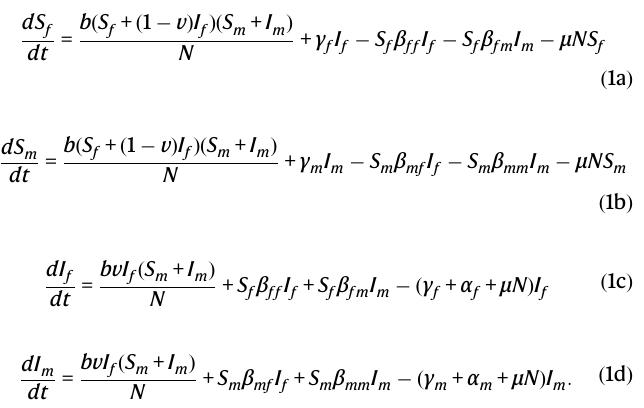
Fig. 7 | Compartmental diagram of the ecological model upon which our co- evolutionary model is based. This model incorporates two sexes (females in red and males in blue) and vertical transmission (dashed line). The fl ow between compartments is represented by arrows and expressions next to each arrow